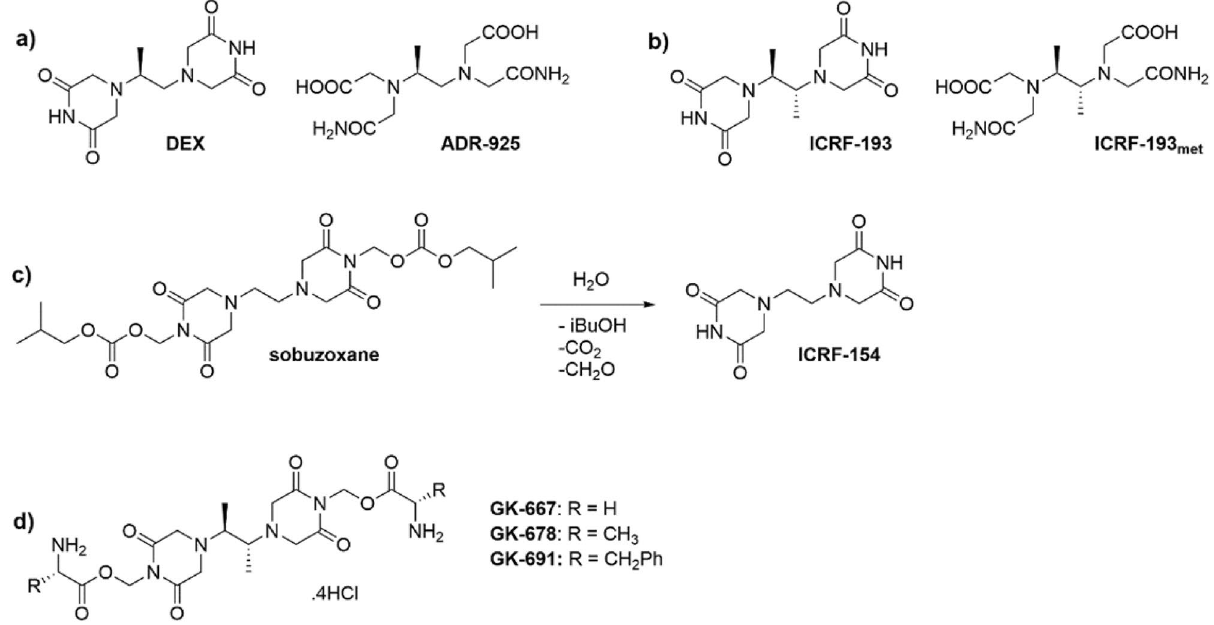
Figure 1. Chemical structures of bisdioxopiperazines, their metabolites and the prodrugs. Chemical structure of ( a ) dexrazoxane (DEX), its metabolite ADR-925 and ( b ) ICRF-193 and its proposed metabolite—ICRF- 193 met . ( c ) The activation pathway of sobuzoxane to ICRF-154. ( d ) General chemical structure of prepared prodrugs of